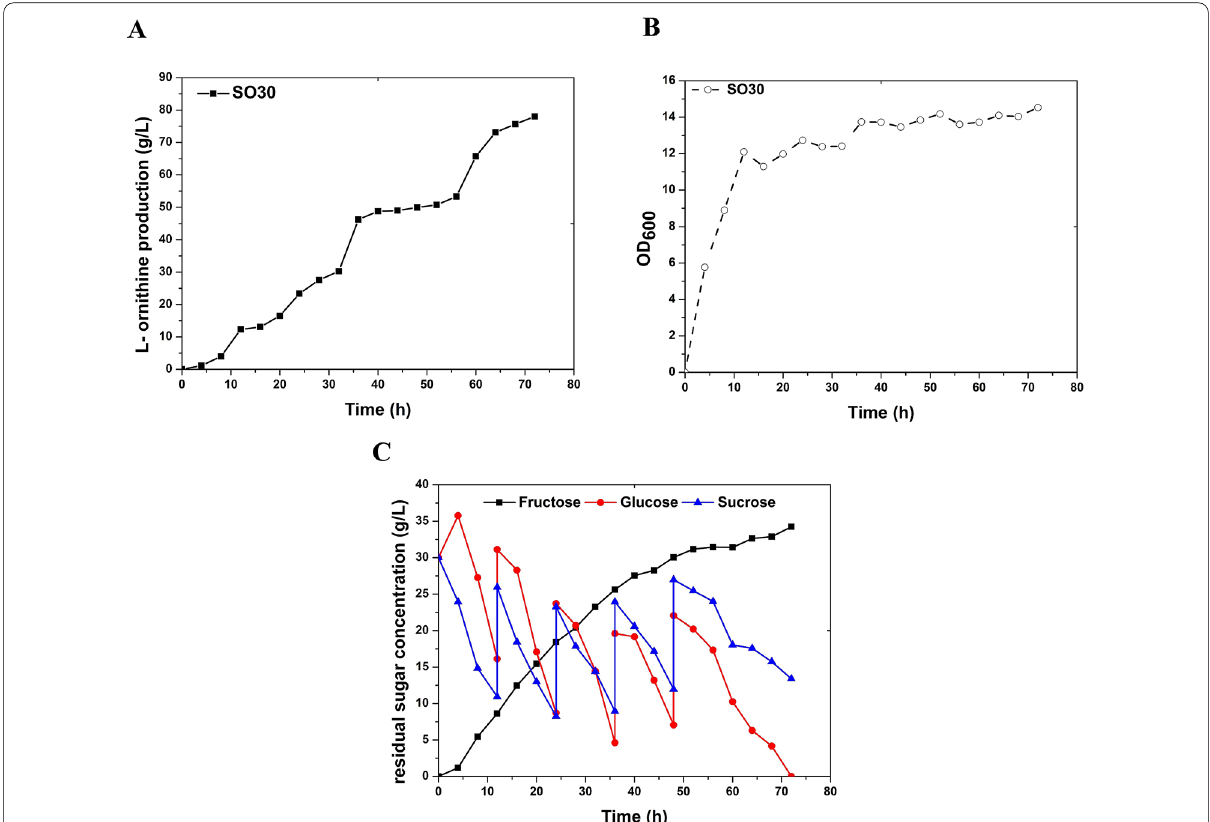
Fig. 5 Fed-batch fermentation evaluation of C. glutamicum SO30 in a 5-L fermenter. A l -Ornithine production curves of strain SO30 in fed-batch cultivation. B Cell growth curves of strain SO30 in fed-batch cultivation. C Glucose (solid red cycle), sucrose (solid blue triangle), and fructose (solid black square) concentrations in the fermentation